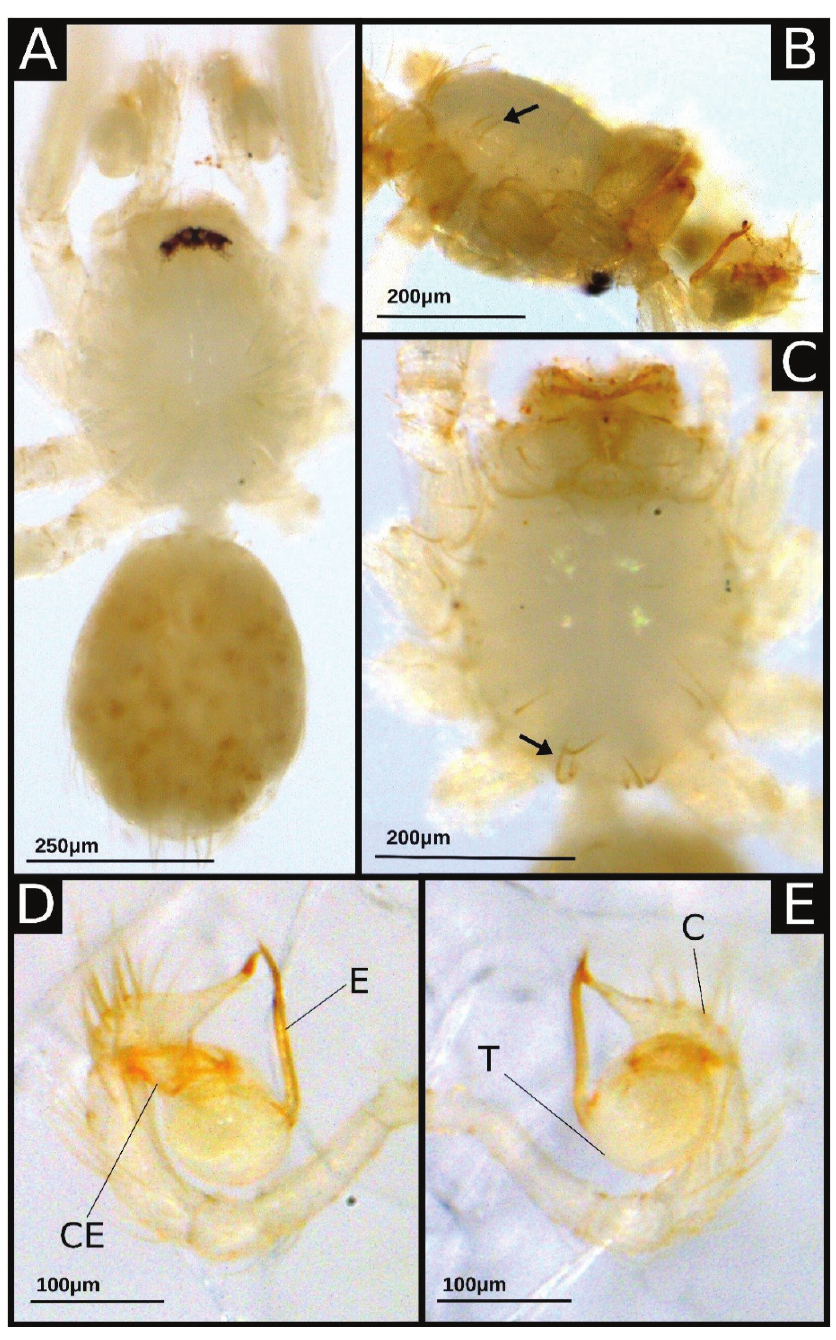
Figure 6. Ochyrocera magali sp. nov., male (IBSP 196412) A habitus, dorsal view B carapace, lateral view, arrows indicating the long and thin setae C sternum, ventral view D male palp, retrolateral view E same, prolateral view. Abbreviations: C, cymbium; CE, cymbial extension; E, embolus; T,